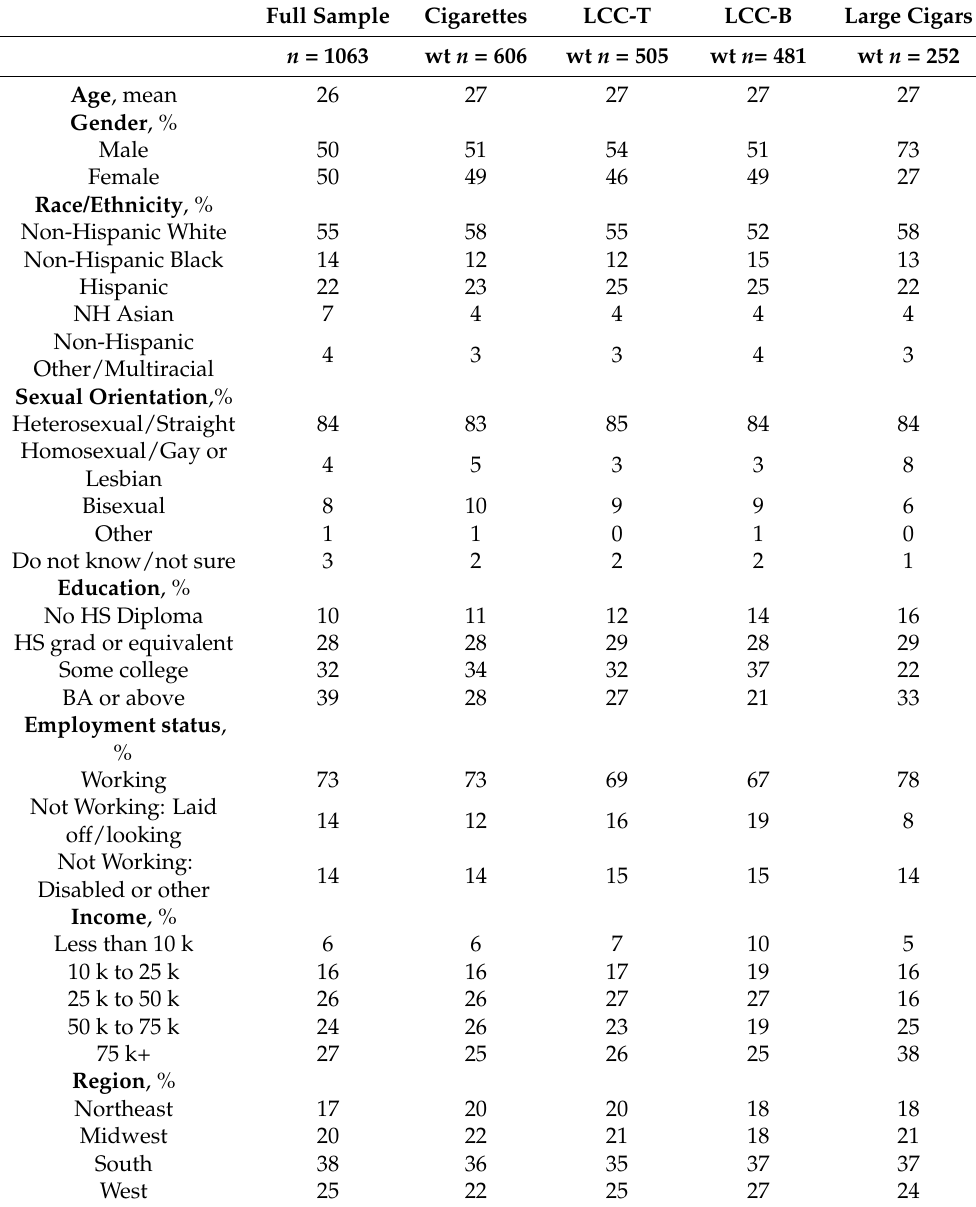
Table 1. Young Adult Sociodemographic Factors by Combustible Tobacco Product Use, Weighted to U.S.-Representative